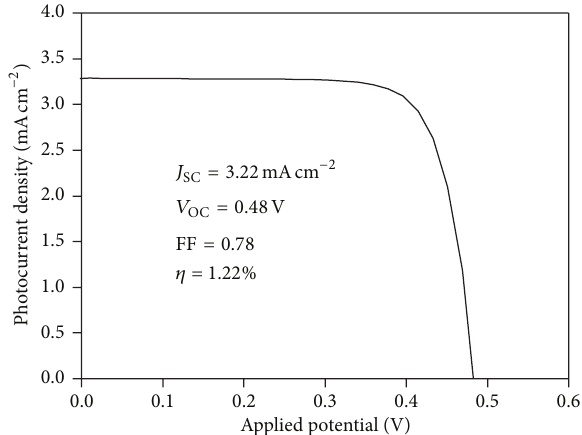
Figure 4: Photograph of a working large-area DSC with Hepta4